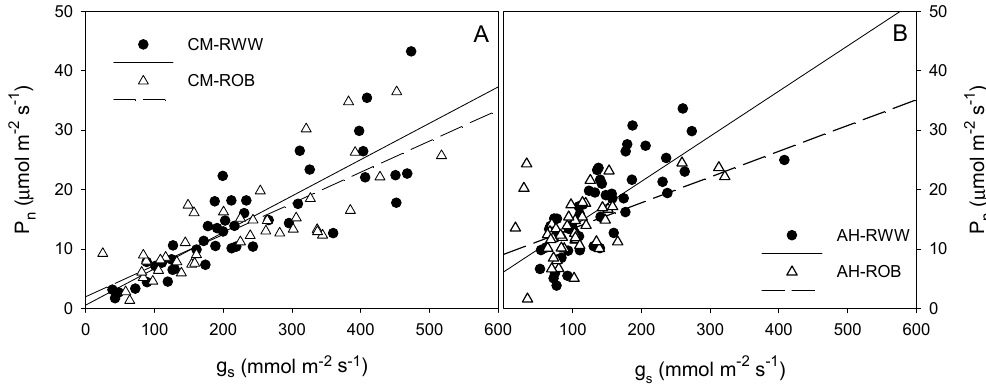
Figure 3. Photosynthetic efficiency as the relationship between photosynthesis and stomatal conductance in Crithmum maritimum (CM) ( A ) and Atriplex halimus (AH) ( B ) irrigated with reclaimed wastewater (RWW) and reverse osmosis brine (ROB).